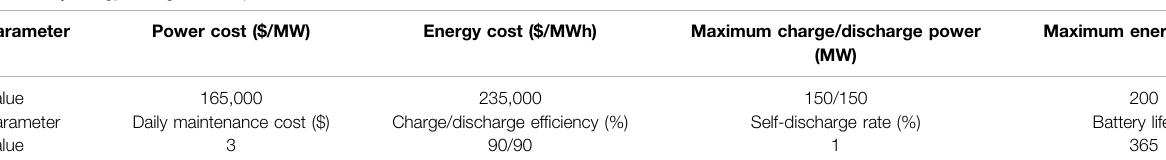
TABLE 1 | Energy storage device parameters.